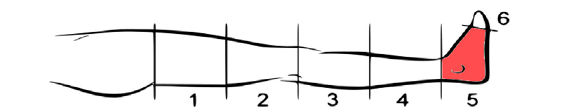
FigUre 4 | Example of targeted monopolar configuration used for the phantom motor execution treatment of the patient with lower-limb